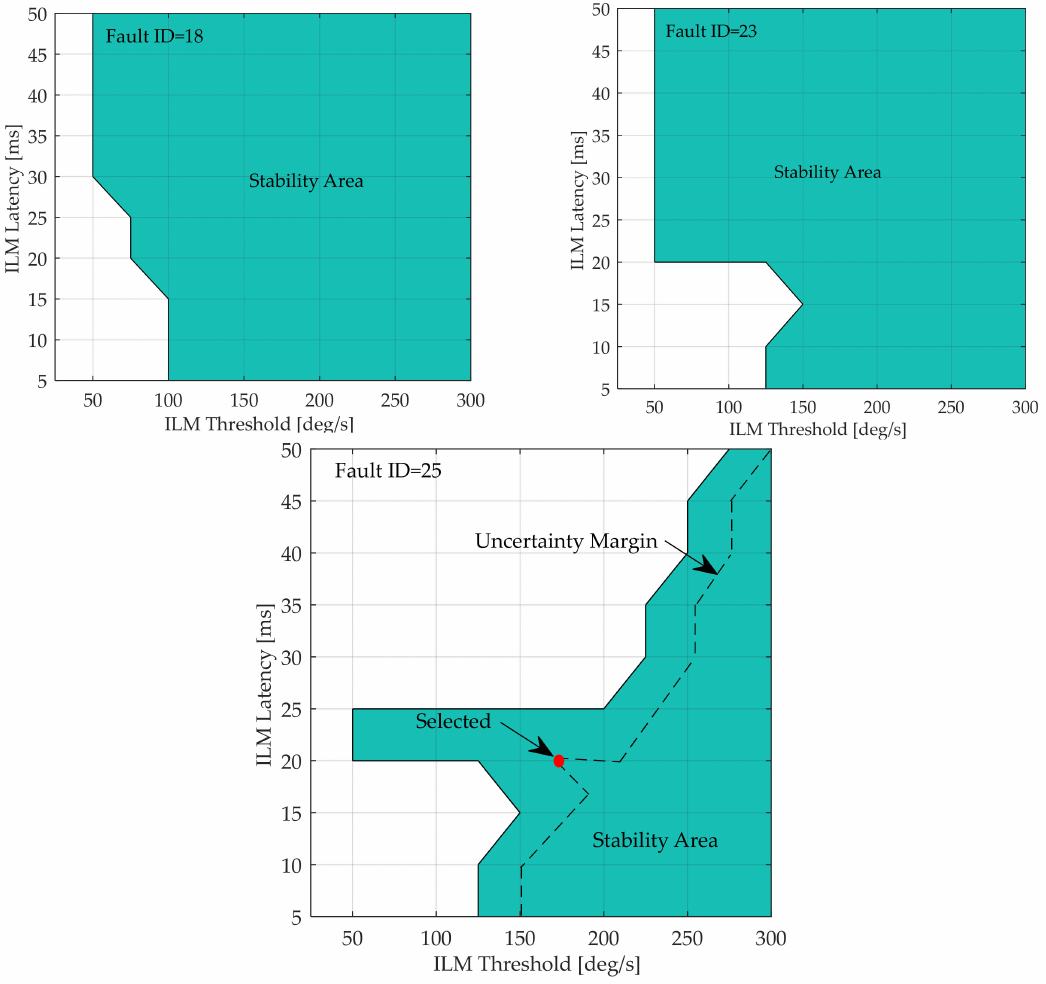
Figure 18. Stability constraint maps for ILM functions for fault ID = 18, 23 and